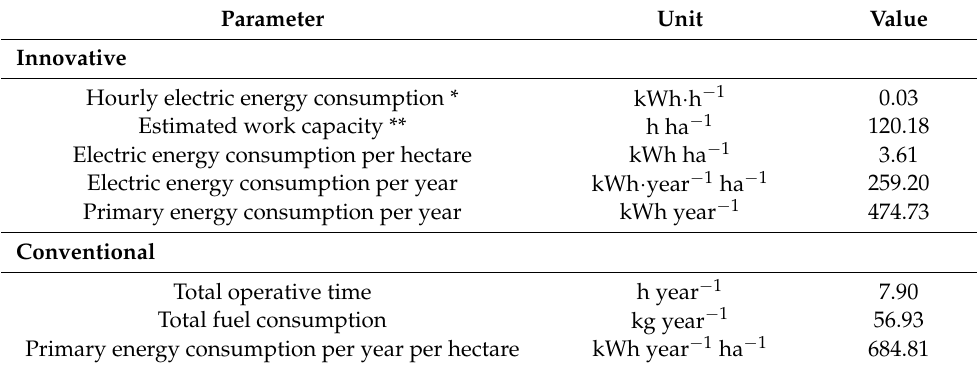
Table 5. Operative characteristics and energy consumption estimation according to different vineyard floor management systems during the two years of the